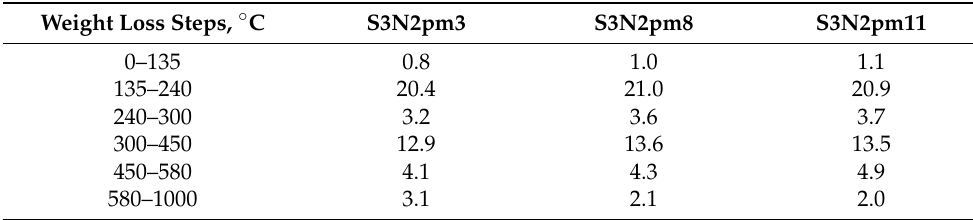
Table 1. The weight losses (%) of smectite–urea composites according to TG curves. Weight Loss Steps, ◦